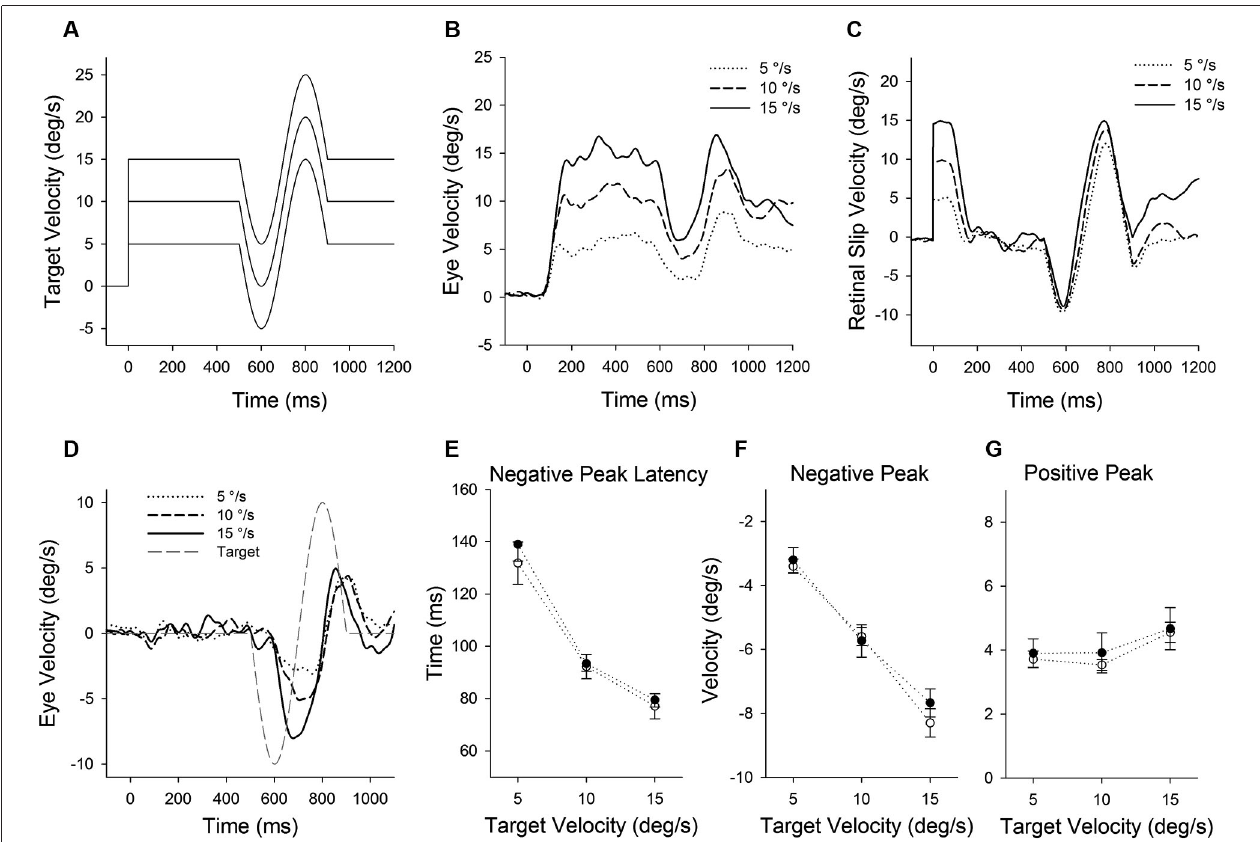
calculated as the difference between eye velocity with and without the perturbation at different ramp velocities (5, 10 and 15 ◦ /s). (E) Mean and standard deviation (SD) values of negative peak latency, (F) modulation of negative peak and (G) positive peak are shown as a function of target velocity. Open and filled symbols indicate monkey-P and B,